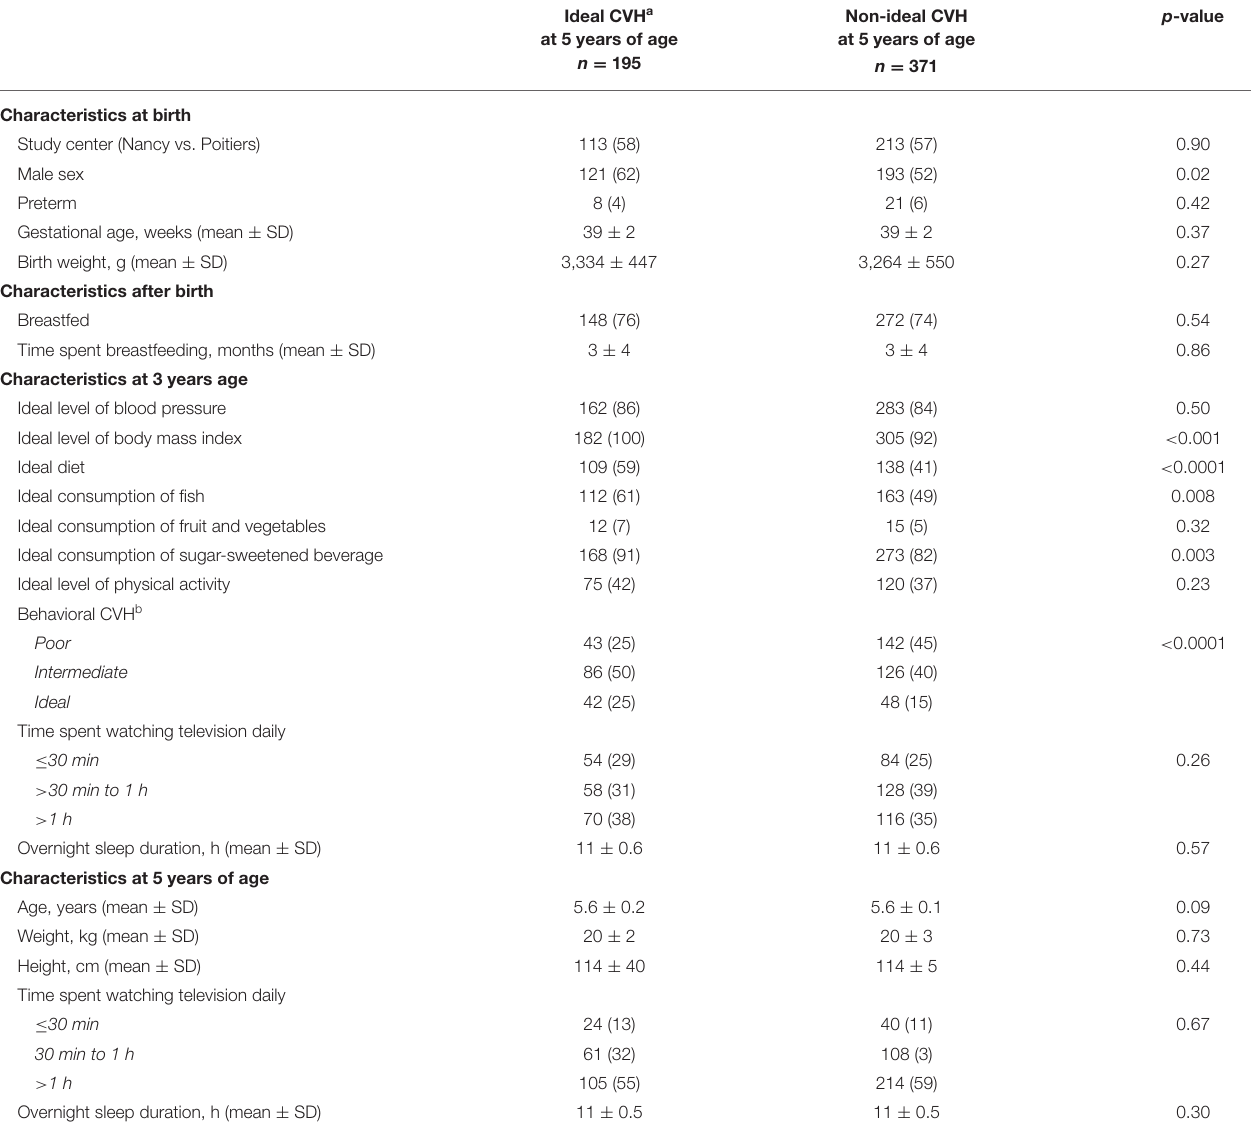
TABLE 1 | Early life characteristics in children with and without ideal cardiovascular health (CVH) at 5 years of